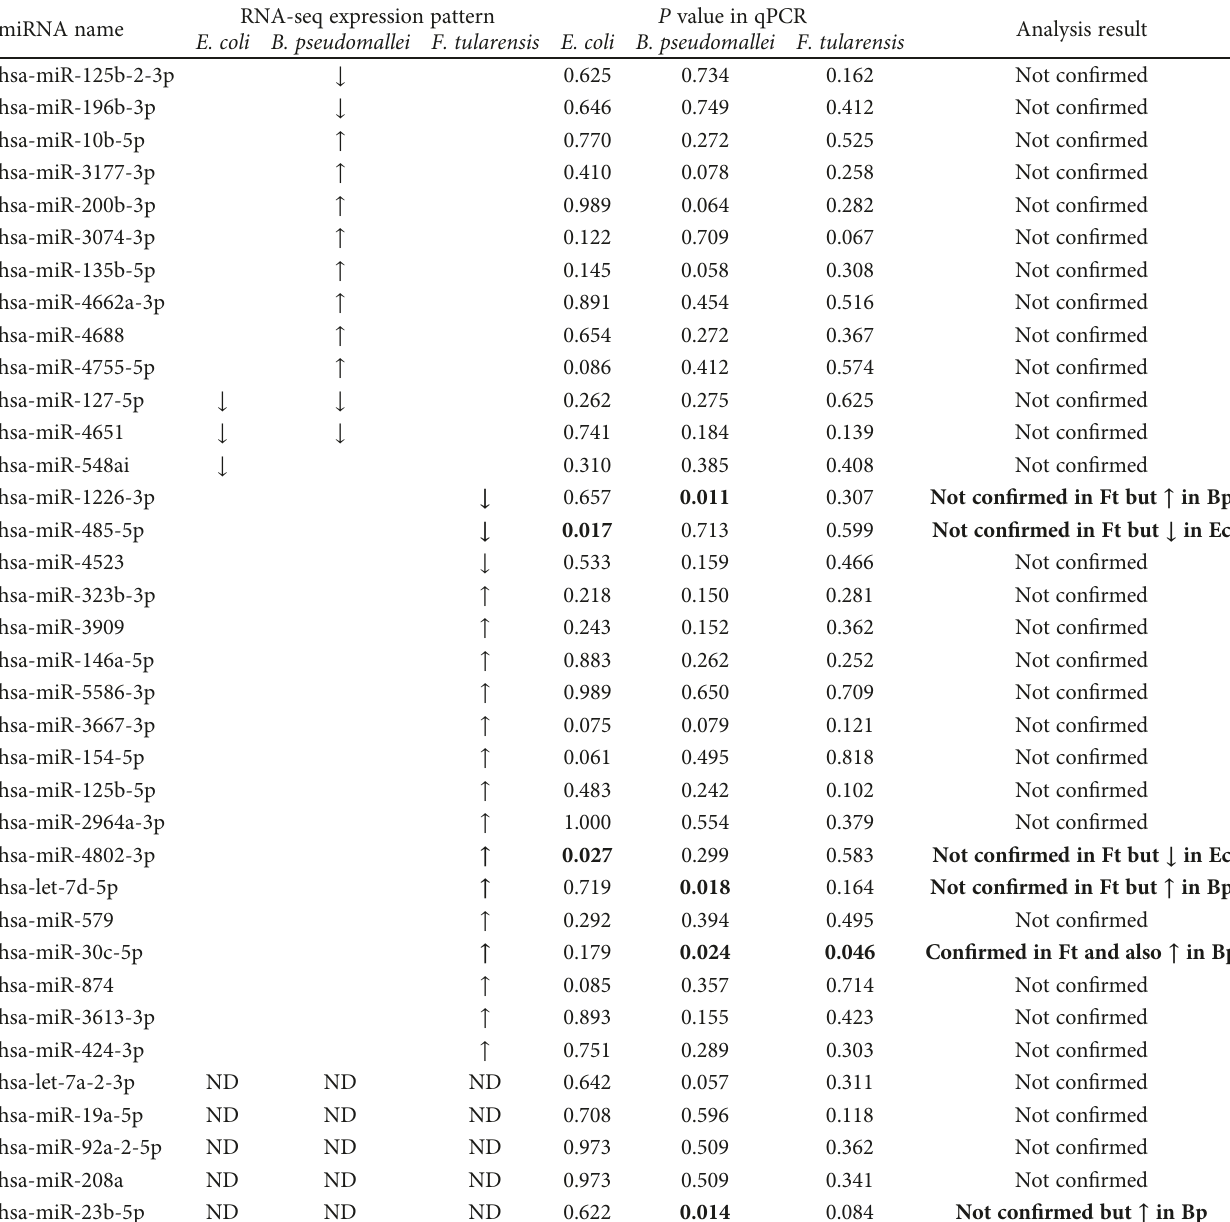
Table 1: Summary results of expression pro fi les in RNAseq versus